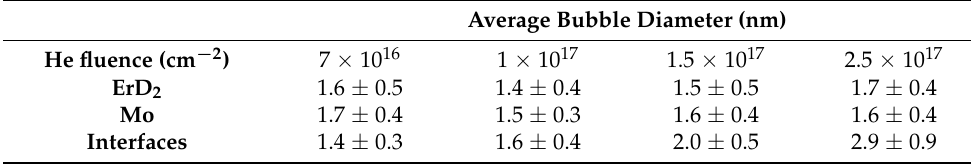
Figure 5. HAADF images of bulk implanted multilayers, showing He bubble microstructure as a function of fluence in ( a – d ) with SRIM He implant profile overlay in ( a ). He-filled bubbles and cracks appear darker than the matrix in the images and increase in size with increasing fluence. Arrows indicate signs of bubble coalescence and cracking along multilayer interfaces in ( b , c ). The image in ( d ) was taken in a region between blisters. Arrows in ( d ) indicate large nanocrack formation at multilayer interfaces. Bubbles appear dark due to the Z-contrast sensitivity of HAADF imaging. Table 3. Average He bubble diameter at each ex-situ He implantation fluence.